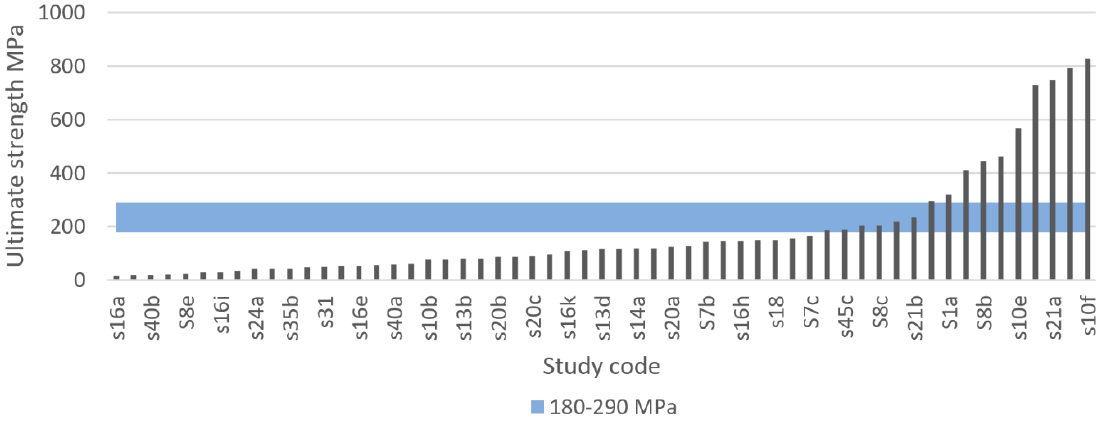
Figure 17. Ultimate compressive strength of porous metamaterials based on triply periodic minimal surfaces (TPMS) compared with the Ideal Quality Attribute (IQA) target zone.